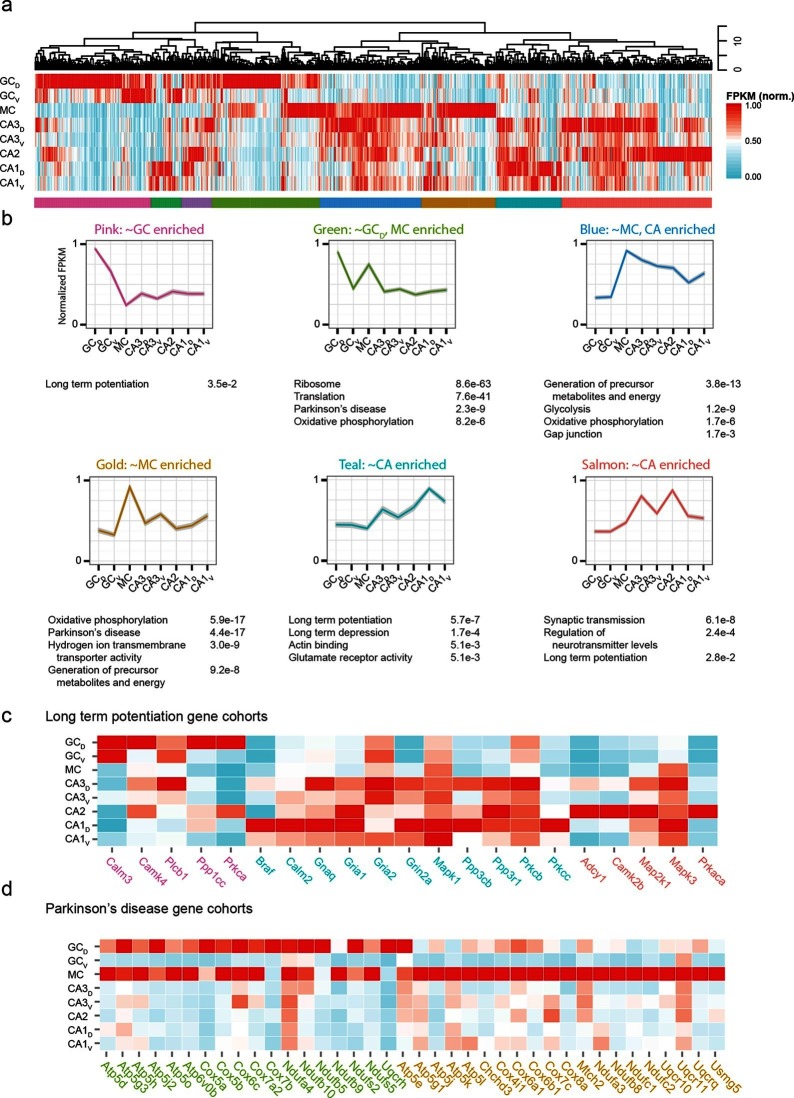
Weighted gene co-expression network analysis (WGCNA) of hippocampal excitatory neuron transcriptomes.(a) Top and middle: hierarchical clustering and normalized expression of the 1000 most variable genes, respectively. Bottom: colors denoting the modules obtained from WGCNA. (b) Six modules obtained from a, with the average expression shown and significantly enriched terms highlighted. Each module is named according to the gross overall expression profile across datasets. (c) Genes associated with long-term potentiation significantly enriched in modules. (d) As in c, but with genes associated with Parkinson’s disease.